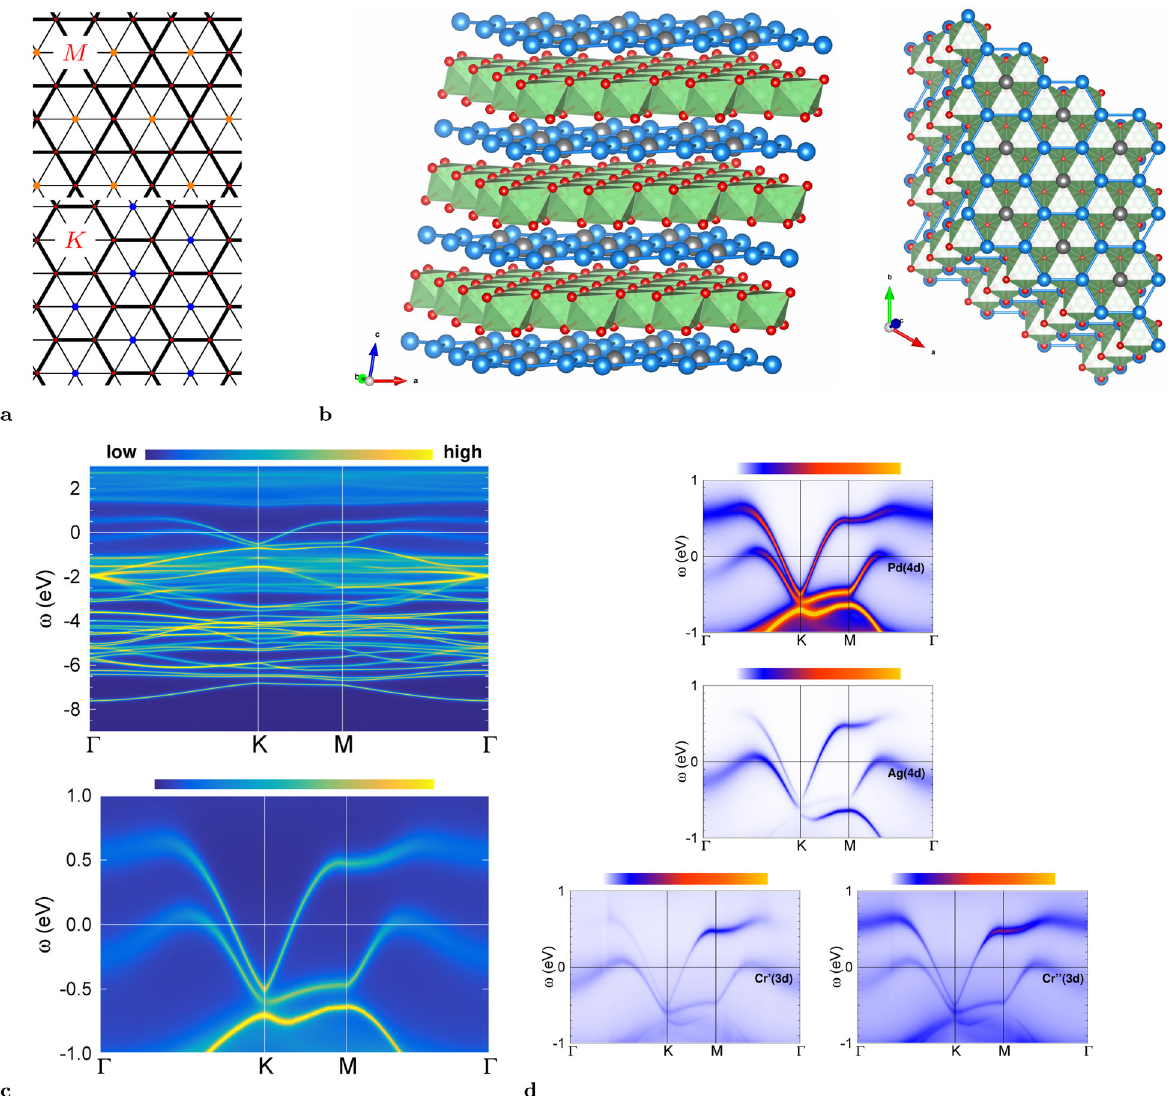
Fig. 10 Effective-honeycomb (Pd,Ag)CrO 2 delafossite. a In-plane design of the A layer via the natural triangular-lattice ordering instabilities of K-point (honeycomb) and M-point (kagomé) kind (from 109 ). b Designed crystal structure from understanding Pd(Ag) positions as active (blocking) sites; Pd: blue, Ag: grey, O: red; Cr: green. Left: 3D view and right: view onto the effective honeycomb lattice of Pd sites. c , d Interacting spectral information from DFT + DMFT at T = 193 K. ( c ) Spectral function in (top) larger and (bottom) smaller energy window. d Orbital-site content ('fatbands'), from top to bottom: Pd(4 d ), Ag(4 d ) as well as both symmetry-inequivalent Cr(3 d ), i.e., Cr'(3 d ) and Cr''(3 d ) (see